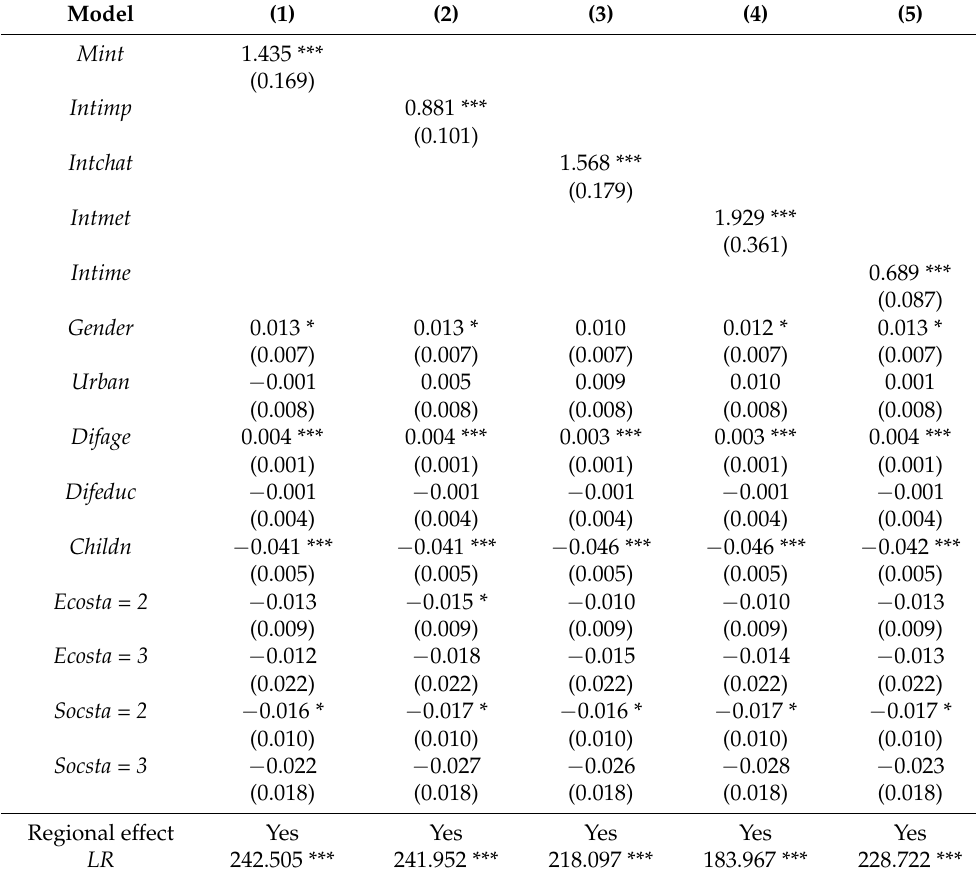
Table 3. Estimated results for the effect of Internet use on divorce risk ( N =